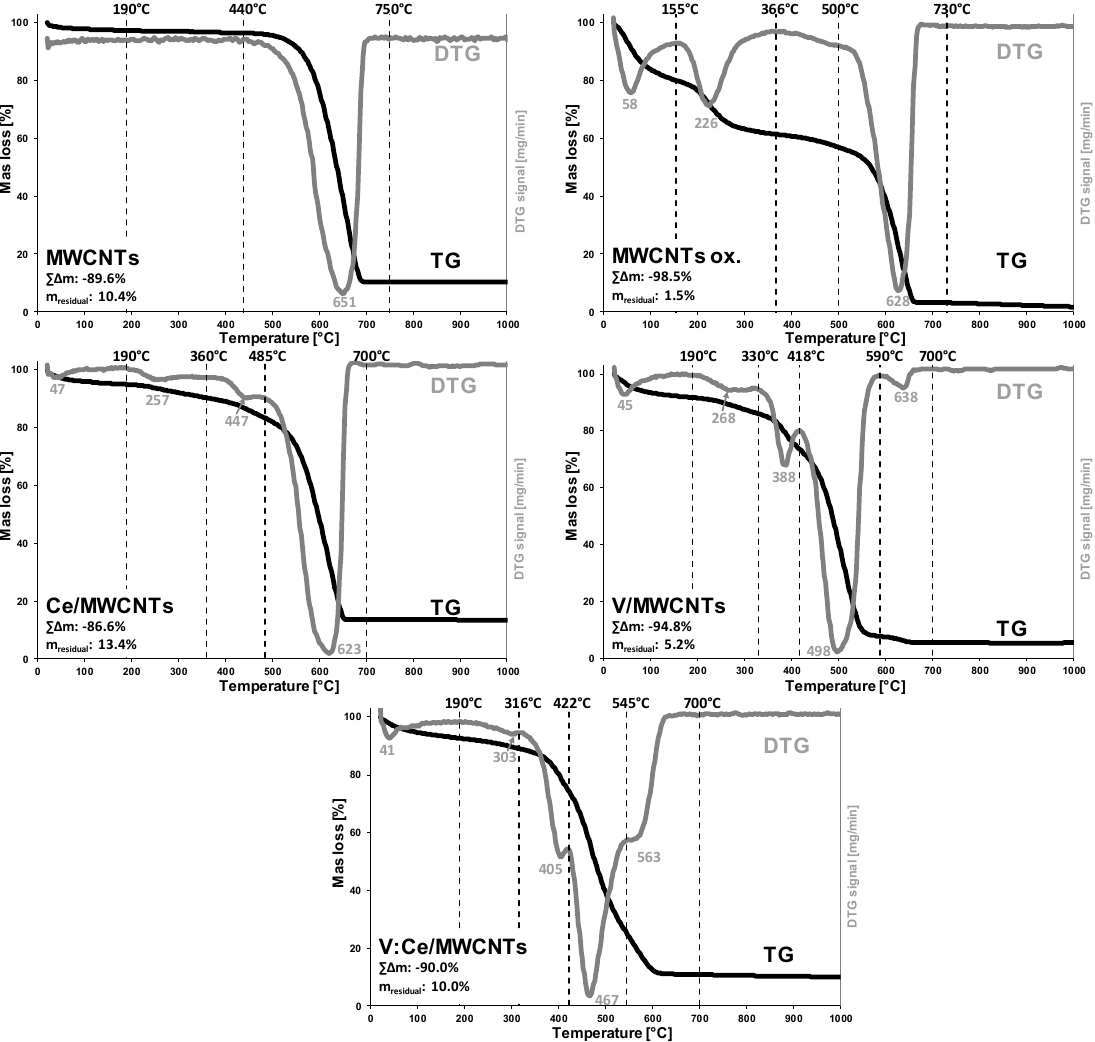
020406080100 020406080100 -7.5-6.5-5.5-4.5-3.5-2.5-1.5-0.5 -7.7-6.7-5.7-4.7-3.7-2.7-1.7-0.7 -1.1-0.1 DTG % ] -6.1-5.1-4.1-3.1-2.1 ss [ TGV:Ce/MWCNTs ∑Δm: -90.0% m residual : 10.0% Temperature [°C] Figure 7. Thermogravimetric curves (TG/DTG) of the MWCNTs samples. As a result of surface treatment using strong acids, the MWCNTs structure is oxi- dized via the introduction of oxygenated-surface functional groups (carboxyl, carbonyl, hydroxyl) [51]. The improved hydrophilic nature due to the modified surface-properties of the acid treated MWCNTs sample is indicated by the increased amount of adsorbed water (Figure 7 MWCNTs ox., Table S2 MWCNTs ox., 21–155 ◦ C). Oxidation of the